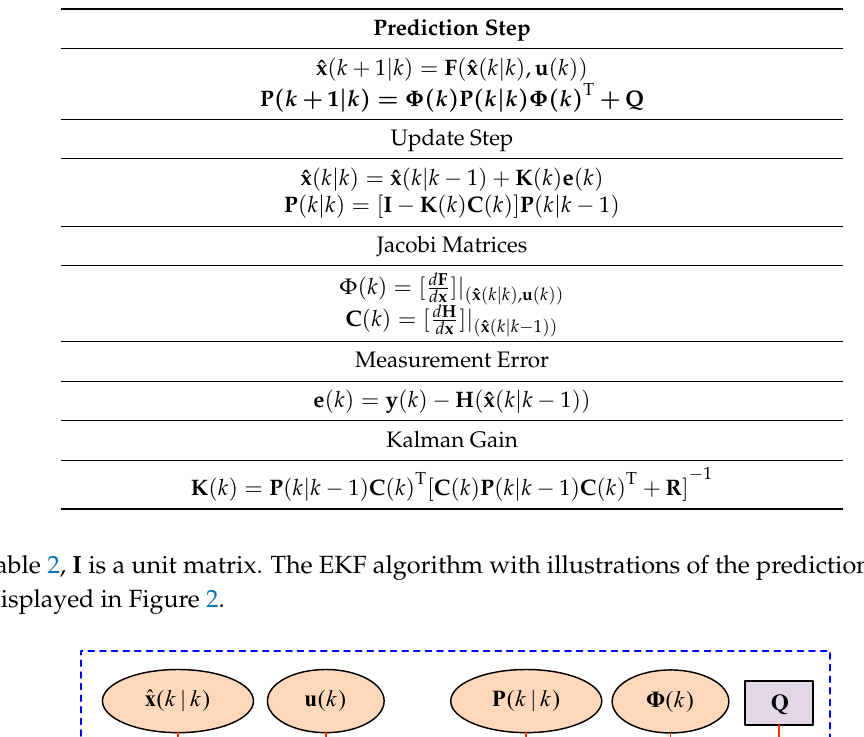
Table 2. Extended Kalman Filter (EKF) algorithm.